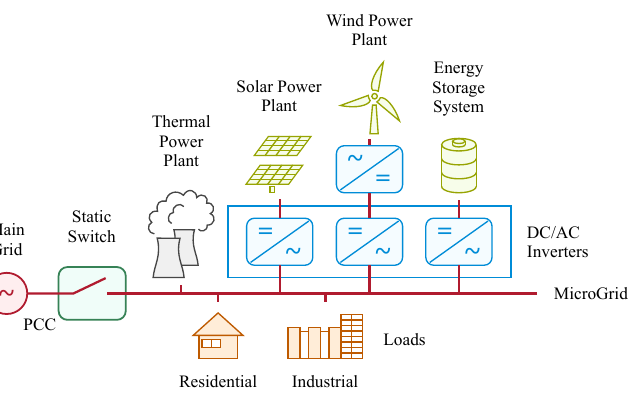
Figure 1. Schematic representation of a typical microgrid. PCC—point of common